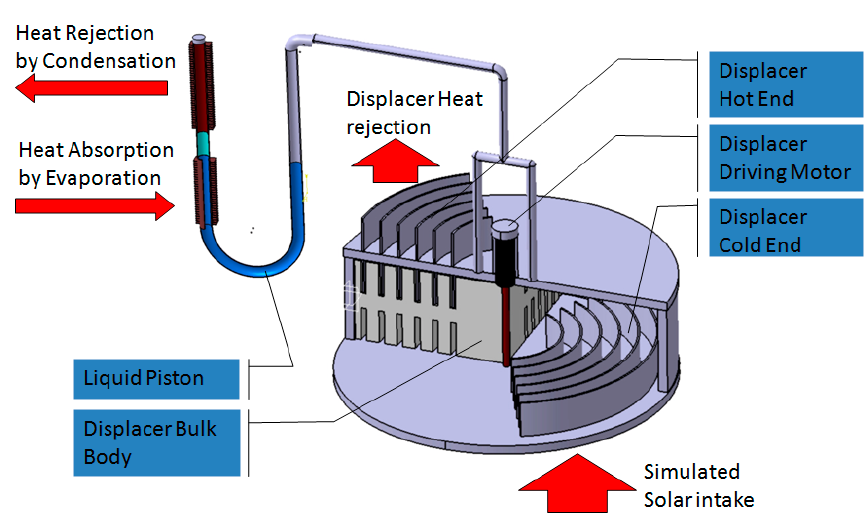
Figure 1. Stirling engine and conditioning unit overview.